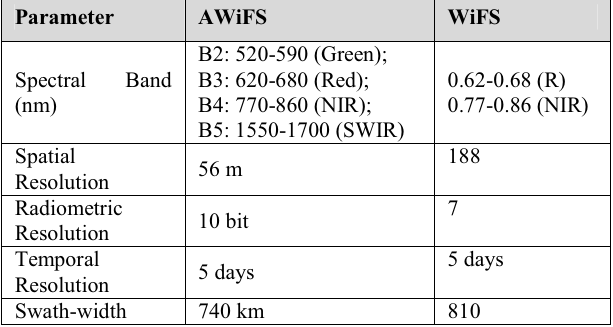
Table 1: Specifications of Resourcesat-1 AWiFS sensor